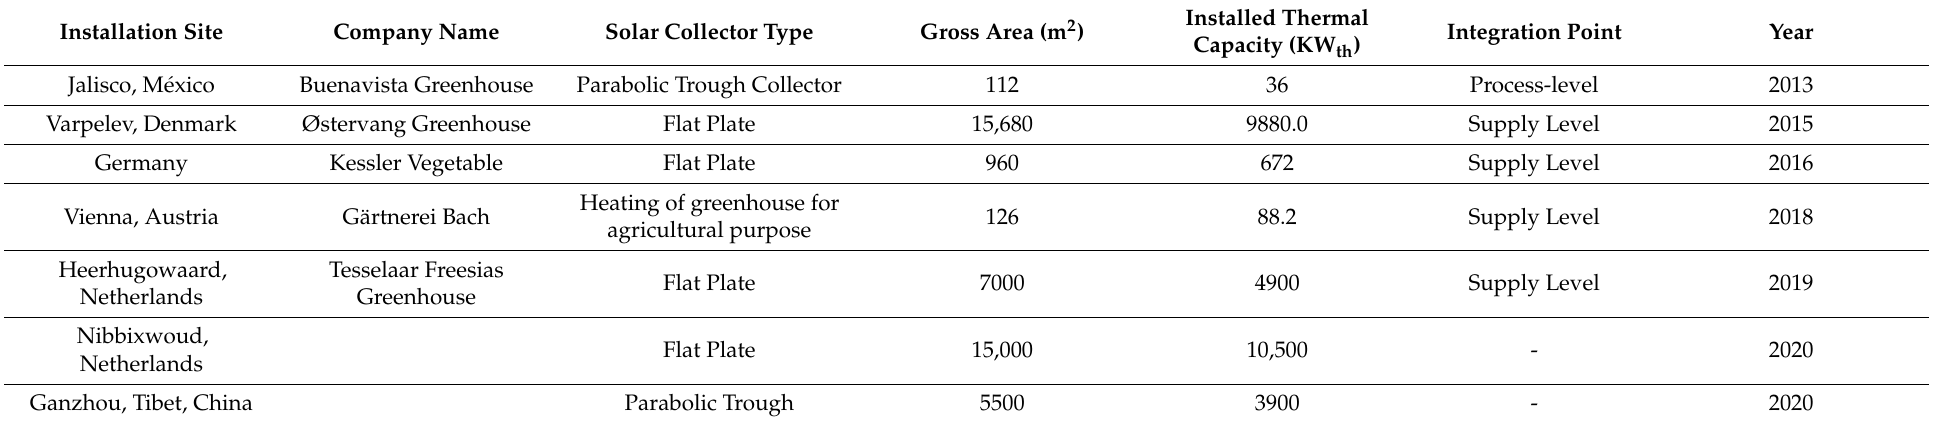
Table 3. Integration scenario in Horticulture Industry